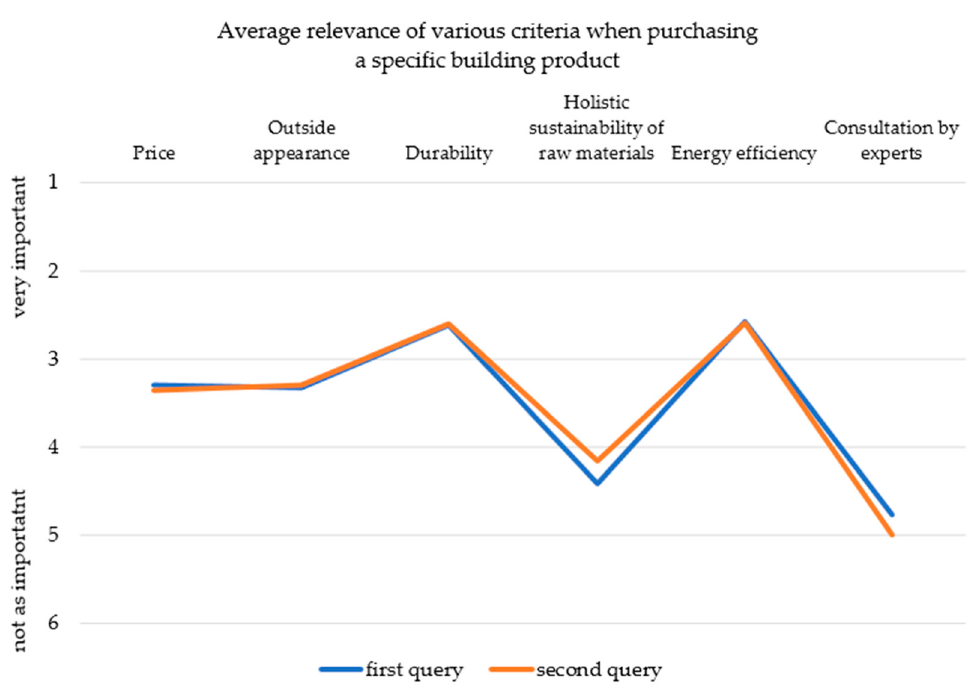
Figure 9. Relevant criteria when making a purchasing decision for a specific building product.